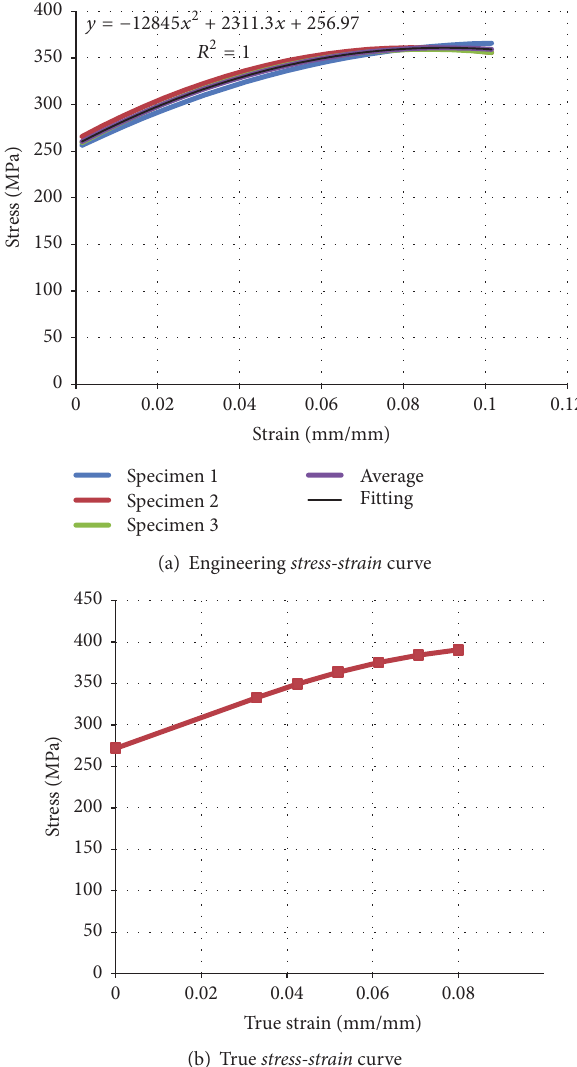
Figure 2: Engineering and true stress-strain